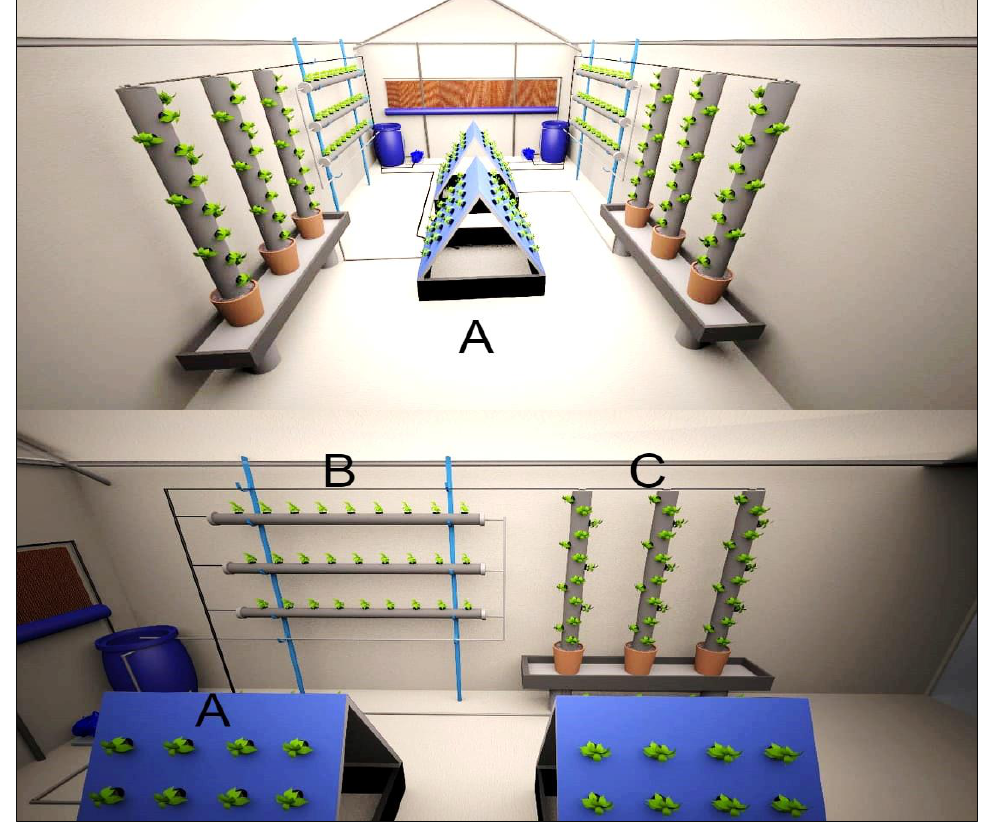
Figure 1. Layout of the environmentally controlled greenhouse and the different soilless culture systems of the experiment. A is the pyramidal aeroponic system, B is the nutrient film technique (NFT) hydroponic system, and C is the tower aeroponic system.